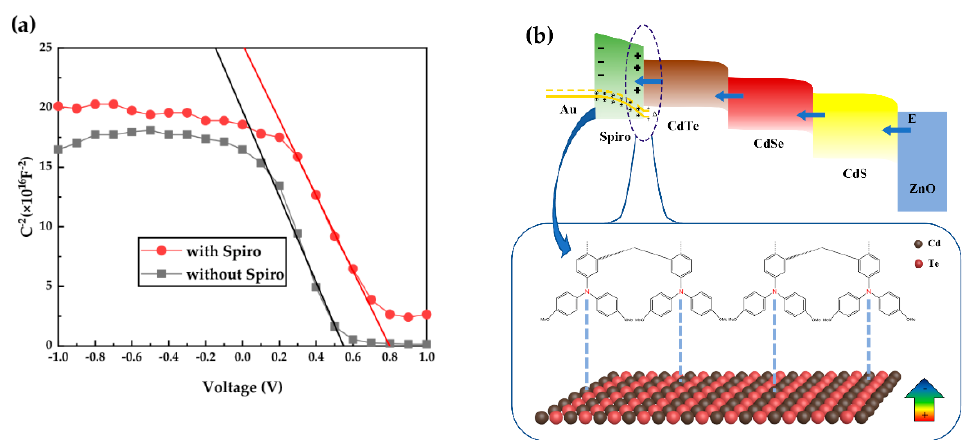
Figure 6. ( a ) Mott–Schottky capacitance − voltage ( C–V ) curves of NC solar cells with / without Spiro; ( b ) a schematic of interfacial dipole and electric field of the NC solar cell with the Spiro HTL.